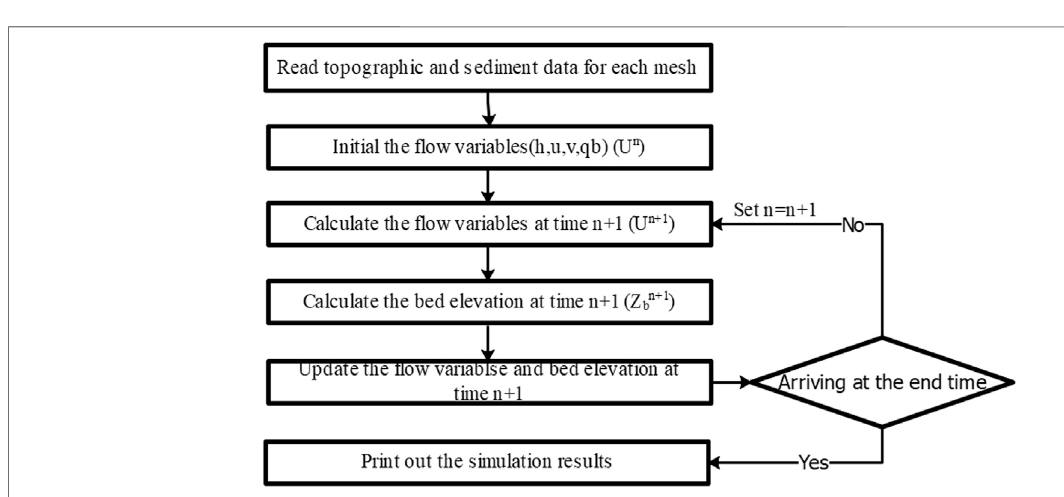
FIGURE 4 | Flow chart of the